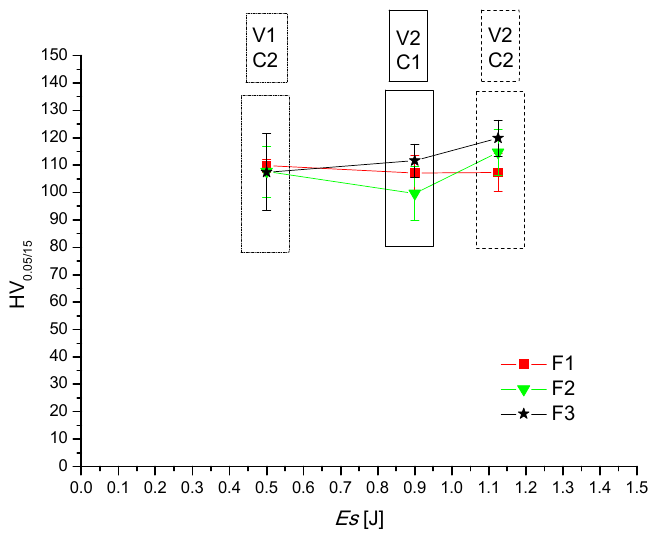
Figure 11. Micro-hardness as a function of the distance from substrate/deposit interface for the different parameters adopted: ( a ) V1, C2, 10 L/min ( Es = 0.5 J); ( b ) V2, C1, 10 L/min ( Es = 0.9 J) and ( c ) V2, C2, 10 L/min ( Es = 1.125 J).